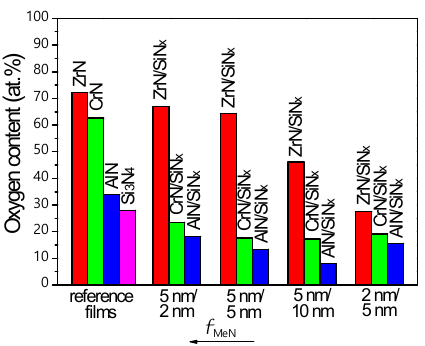
Figure 8. The oxygen content for the reference ZrN, CrN, AlN, and Si 3 N 4 films as well as ZrN/SiN x , CrN/SiN x and AlN/SiN x multilayered films with different ratios of the thicknesses of MeN and SiN x elementary layers after annealing in air at 950 °C.